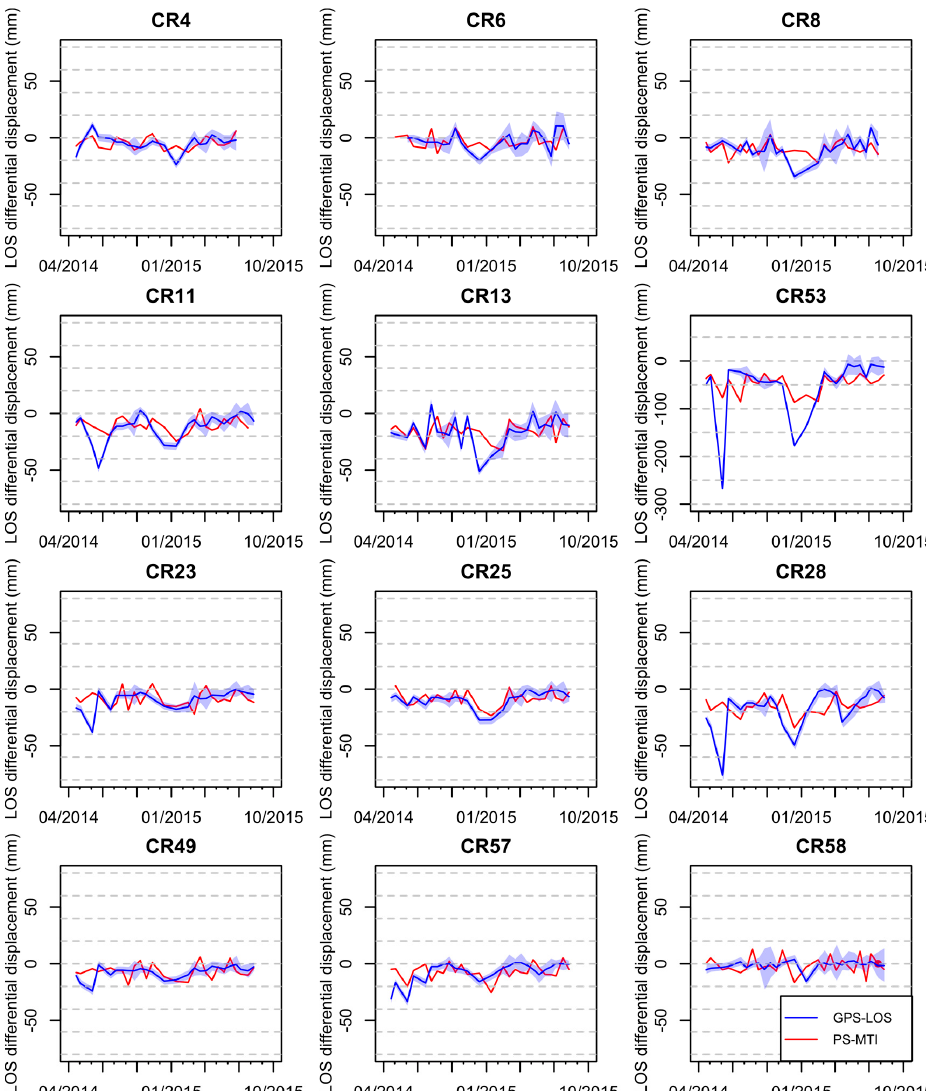
Figure 7. Differential displacements retrieved by PS-MTI (red) compared with GPS validation surveys (blue). The blue shaded areas represent the positioning standard deviation calculated for every GPS acquisition. Note that, due to the large displacements recorded, the diagram of CR53 is out of scale respect to the others.